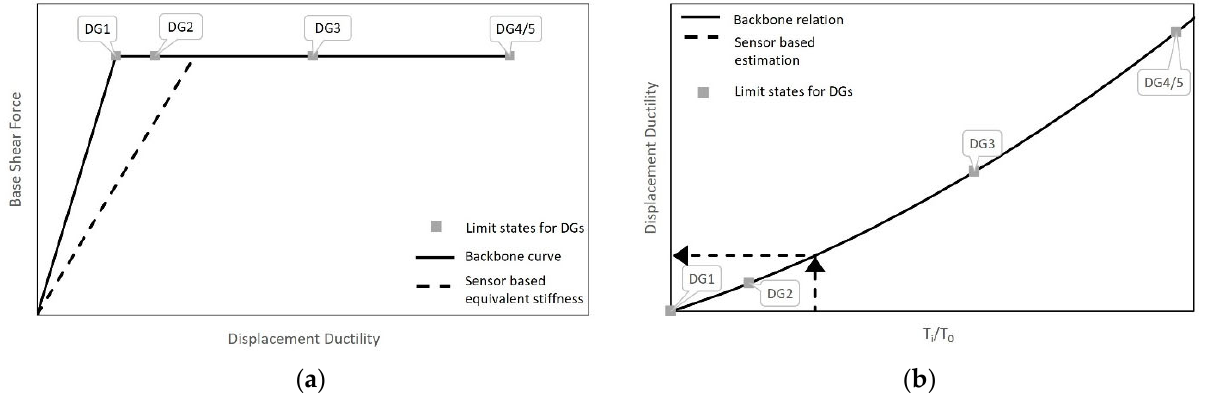
Figure 3. ( a ) Bi − linear backbone curve and performance evaluation using the secant stiffness concept, ( b ) Correlation between period elongation and displacement ductility demand.